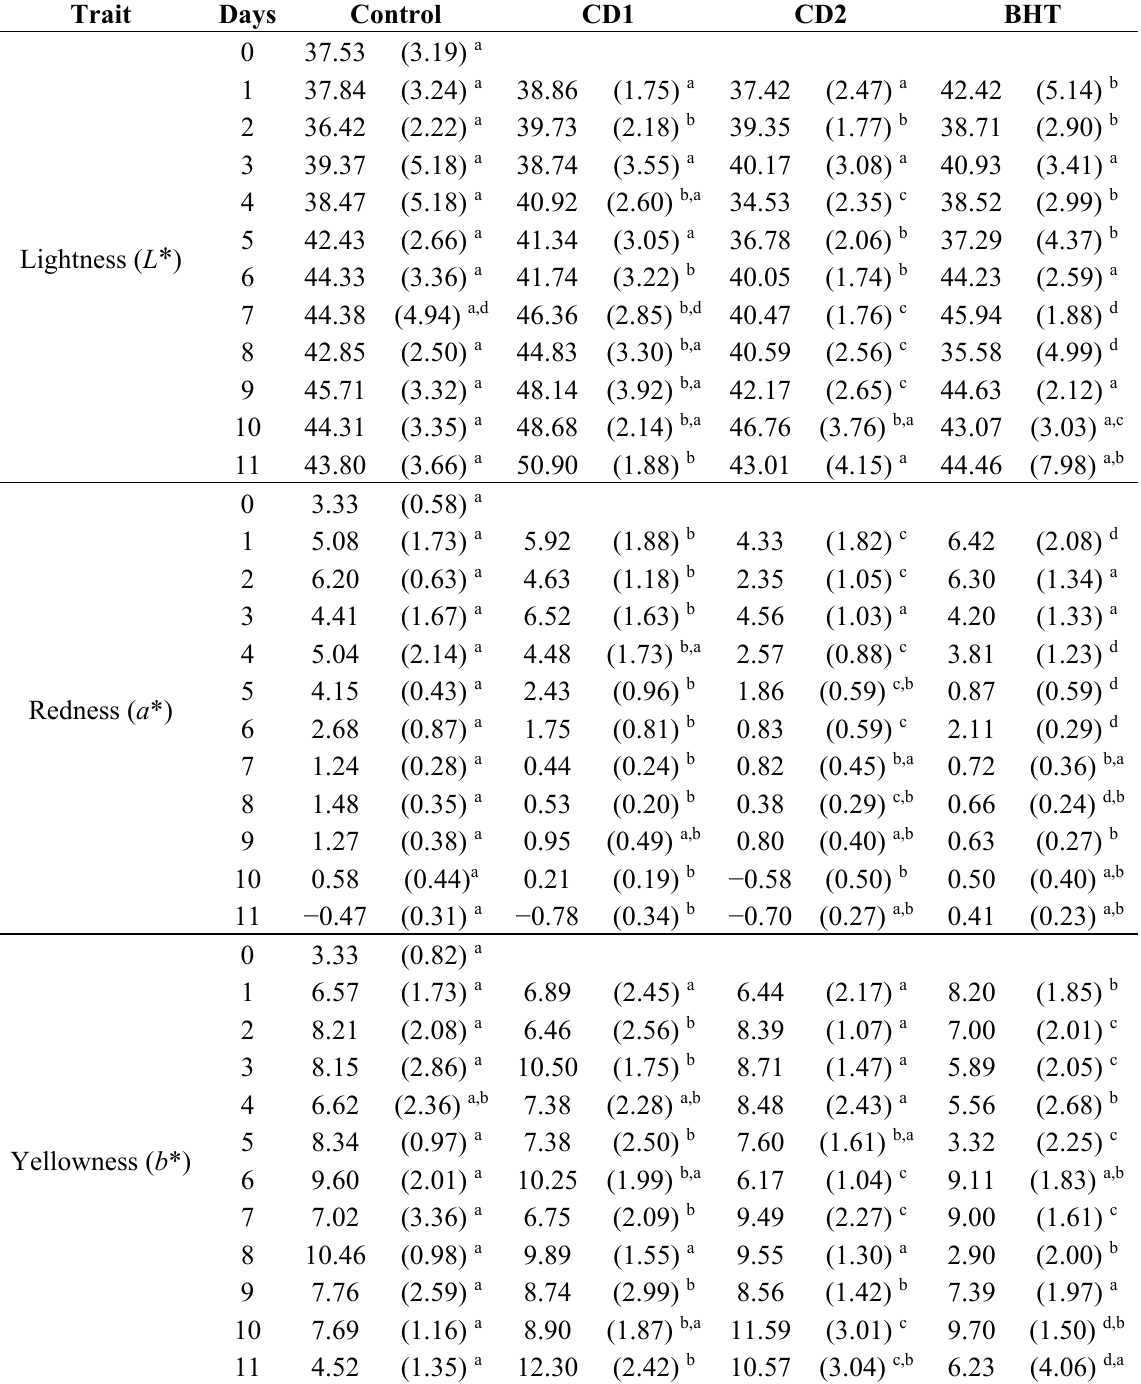
Table 2. Color changes of beef patties containing extracts at 4